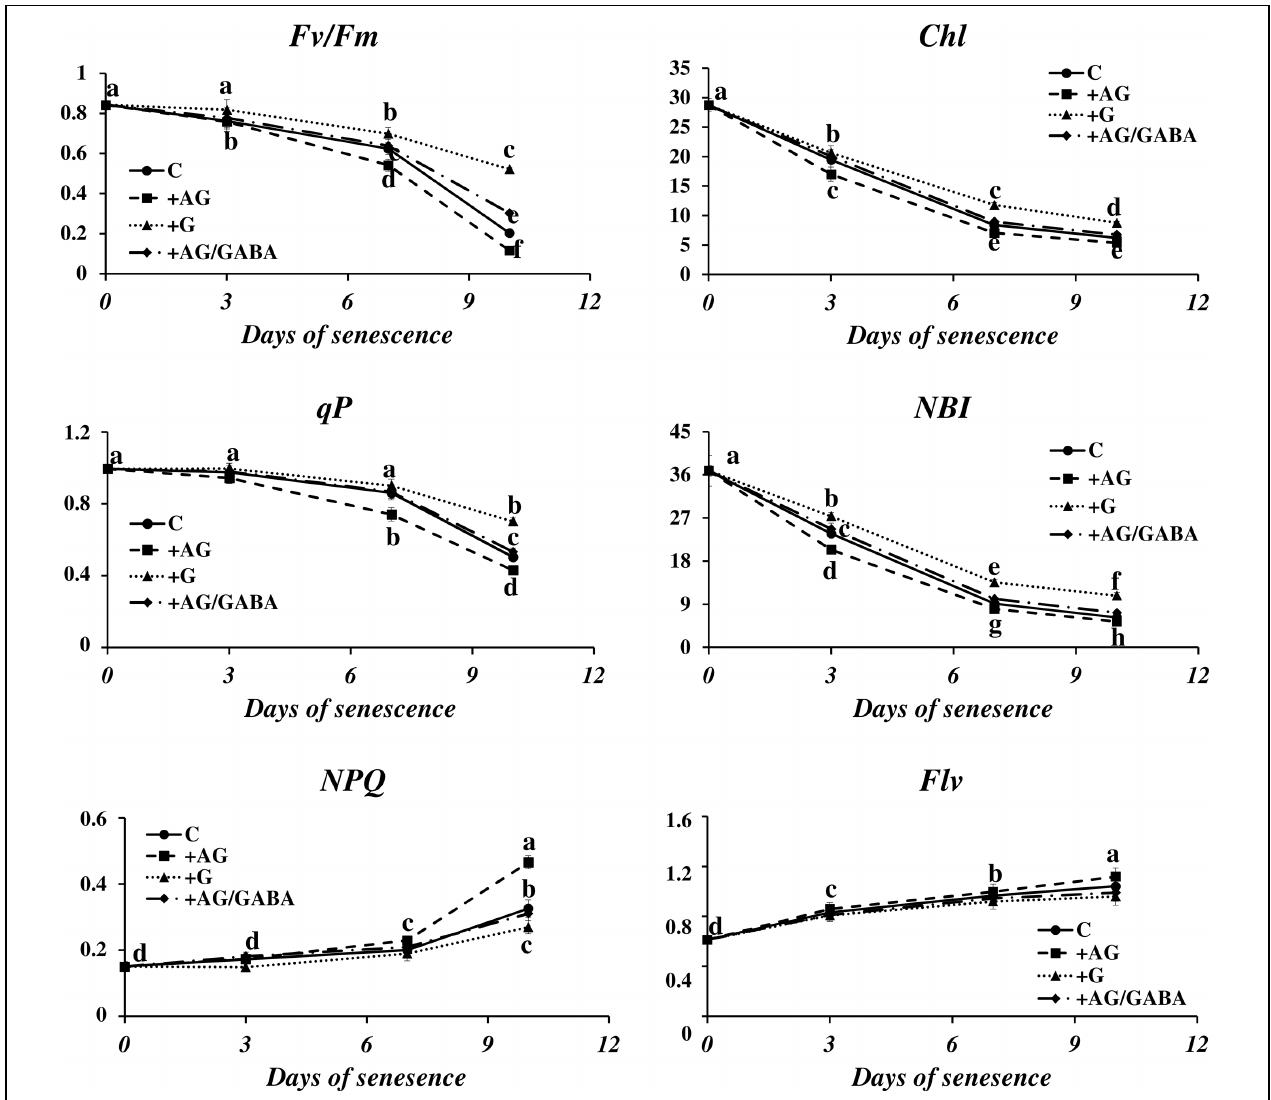
FIGURE 6 | Senescence-related changes in chlorophyll fluorescence and nitrogen status in dark-incubated conditions in the presence of PA catabolism inhibitors in barley leaves. The parameters Fv / Fm , maximum quantum yield of PSII in the dark adapted state; qP , photochemical quenching Chl fluorescence; NPQ , non-photochemical quenching of Chl fluorescence; Chl, chlorophyll level; NBI , nitrogen balance index; and Flv , amount of flavonoids were measured throughout senescence in C (solid line)- control leaves and after application of polyamine catabolism inhibitors: + AG (dashed line) – leaves treated with 10 μ M N,N -diaminoguanidine (AG) – diamine oxidase (DAO) inhibitor; + AG/GABA (dashed-dotted line) – leaves treated with 10 μ M AG and 1 mM γ -aminobutyric acid (GABA); + G (dotted line) leaves treated with 50 μ M guazatine (G) – polyamine oxidase (PAO) inhibitor. Measurements of Chl fluorescence induction kinetics were taken using a pulse amplitude-modulated PAM fluorimeter. For estimation of plant nitrogen status, a method based on fluorometric measurement of chlorophyll/flavonoids ratio with a DUALEX 4 FLAV fluorimeter was used. The differences in the measured parameters were analyzed for statistical significance using one-way ANOVA and the Tukey–Kramer Multiple Comparison Test ( n = 25, p < 0.01). The same letters on bars describe non-significant differences between means.